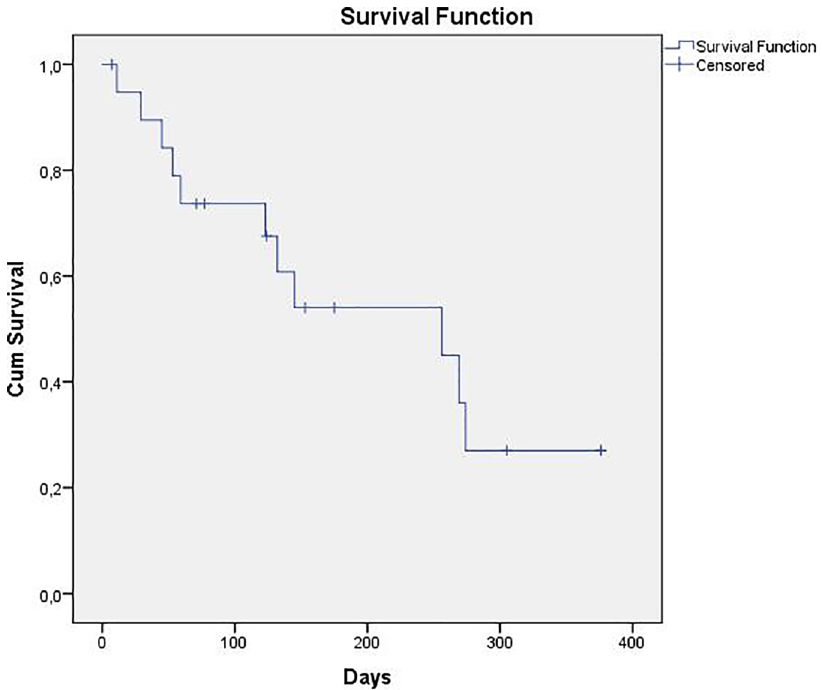
Fig 1. Overall survival curve Kaplan-Meier after first PIPAC